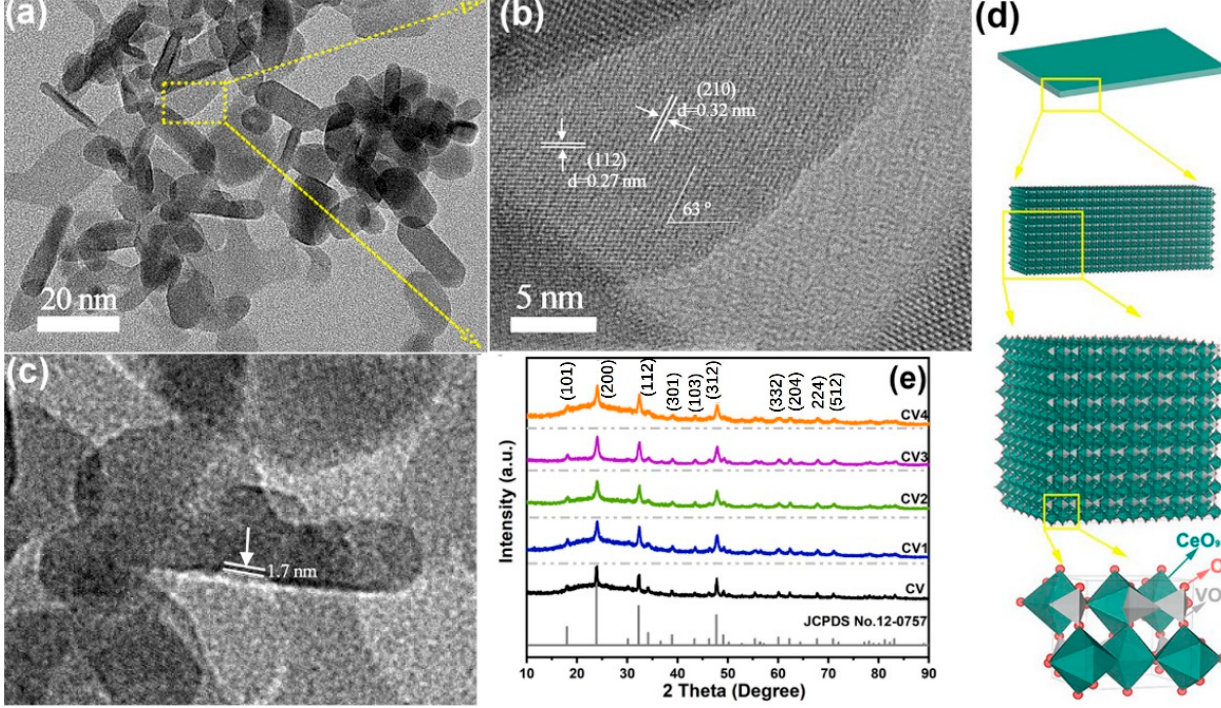
Figure 2. TEM images of CV3 selected from different areas ( a - d ), and AFM characterization of CV3 ( e ).